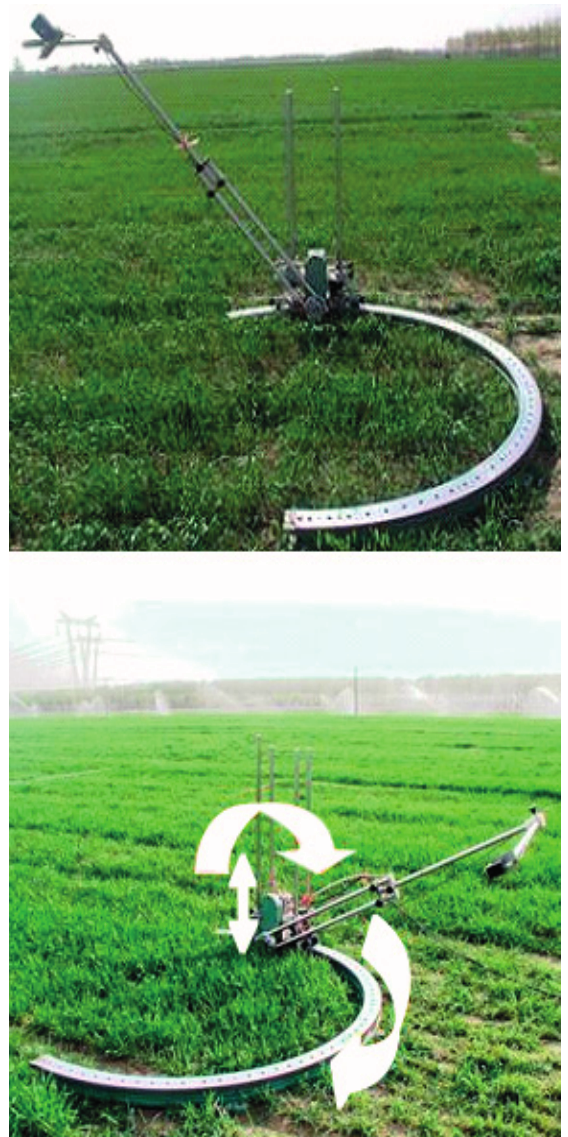
Figure 1. Rotating bracket for observing BRDF canopy